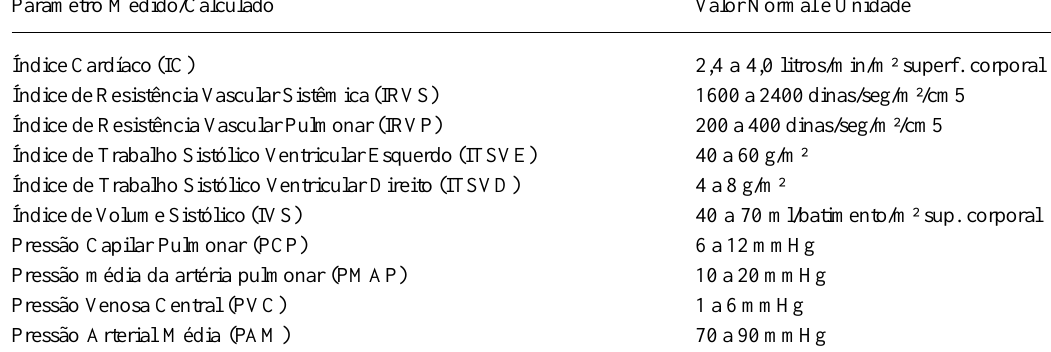
Tabela 3. Parâmetros